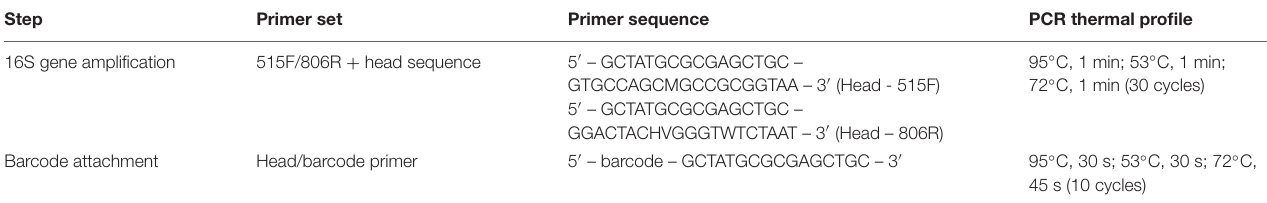
TABLE 1 | PCR programs used for preparation of 16S sequencing samples.